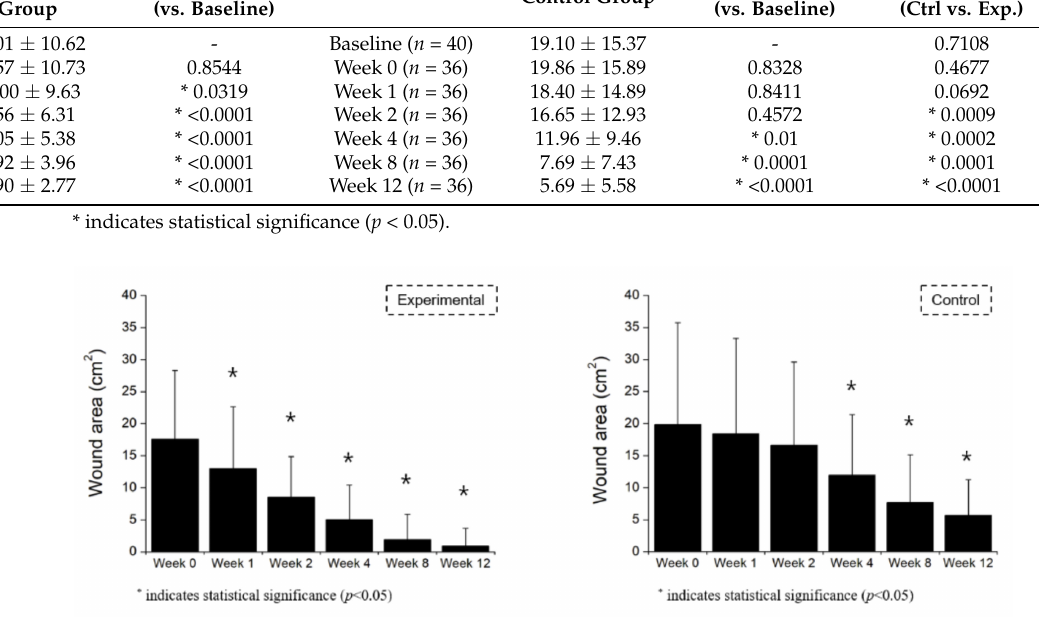
Figure 2. Wound area reduction by